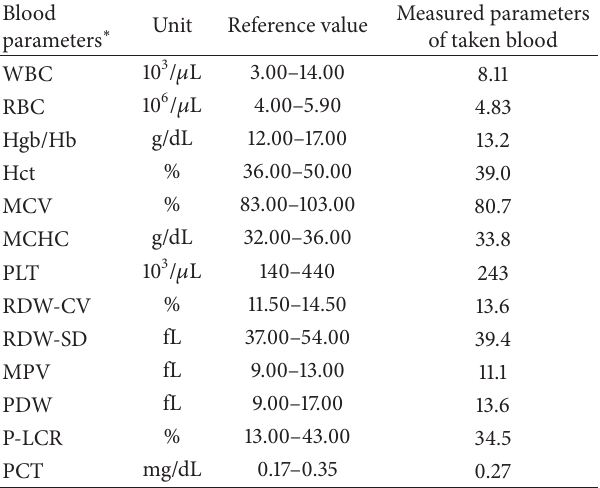
Table 7: Reference values of blood parameters and its value for blood taken to the studies of PU